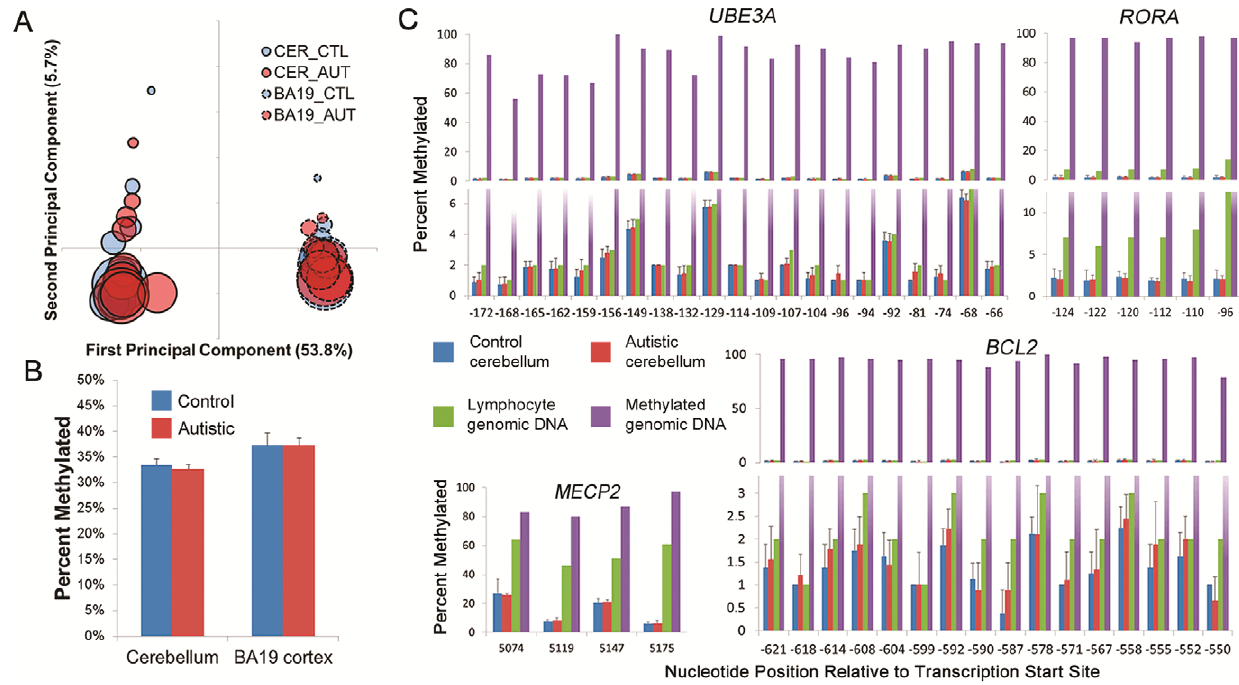
Figure 3. No differential methylation of genomic DNA was identified between control and autism cerebellar cortex or BA19 cortex. ( A ) Unsupervised correspondence analysis of genome-wide CpG methylation in control and autism cerebellar cortex and BA19 cerebral cortex demonstrates that brain region and age are associated with the largest two sources of variability, respectively, in the data. The first two principal components are listed on the x- and y-axis respectively, with percent of variance explained in parentheses. Bubbles correspond to individual samples with area proportional to age of subject, bubble outline to region, and color to phenotype. ( B ) Percent of genome-wide methylated probes in cerebellar cortex or BA19 cortex in control and autism samples. Error bars represent standard deviations. There was no significant difference in global methylation between autism vs control cerebellum or BA19 cortex. There was a significant difference between brain regions, as expected (alpha=0.05; Wilcoxon rank-sum test). ( C ) Pyrosequencing of bisulfite-treated DNA. Percent methylation at individual CpG dinucleotides is reported in cerebellar cortex samples (n $ 7 per group) for a priori candidate genes suspected to exhibit differential methylation. X-axis represents locus relative to transcription start site. Error bars represent standard deviations.